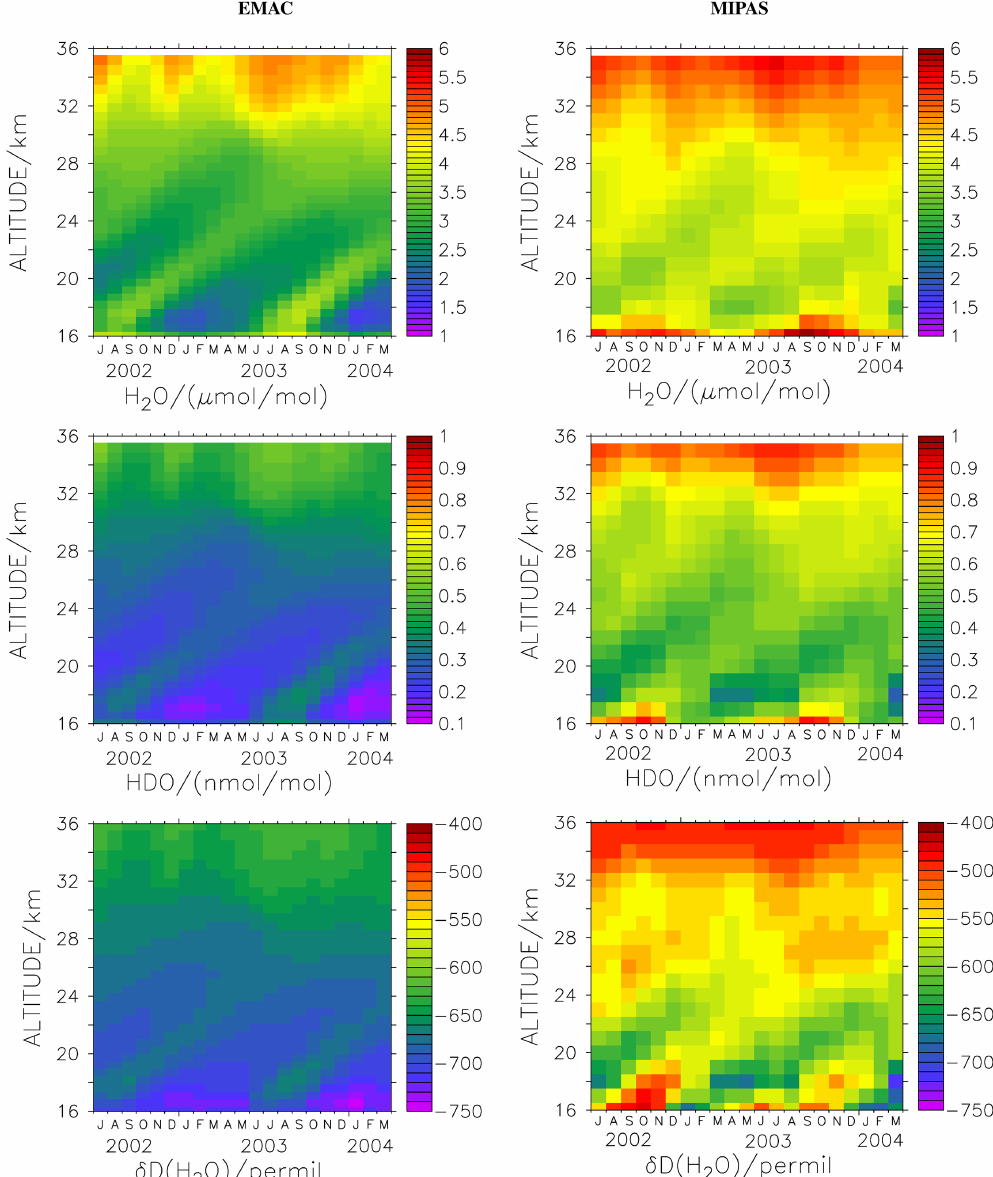
Figure 6. Altitude–time diagrams of H 2 O, HDO and δ D(H 2 O) in the Tropics (15 ◦ S–15 ◦ N). Left: EMAC simulation, right: MIPAS obser-